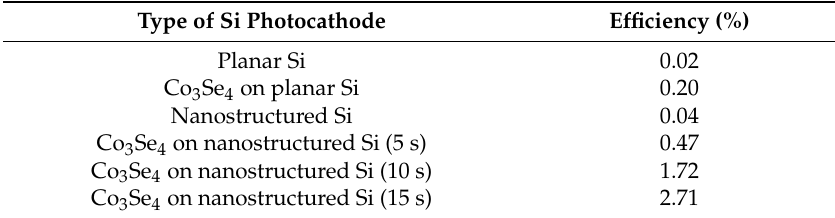
Figure 3. FESEM images Si photocathodes with variation of etching time ( a ) 10 min, ( b ) 20 min, ( c ) 40 min and ( d ) 150 min. Table 1. Half solar-to-hydrogen conversion efficiency of various